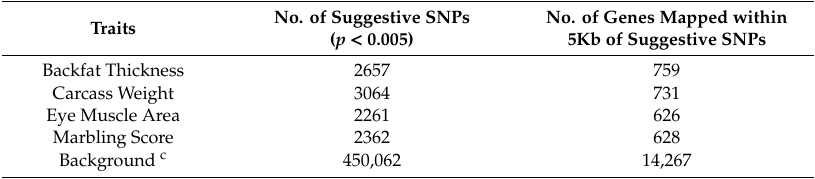
Table 4. Number of significant SNPs identified from the genome-wide association study (GWAS) and the genes that were mapped to